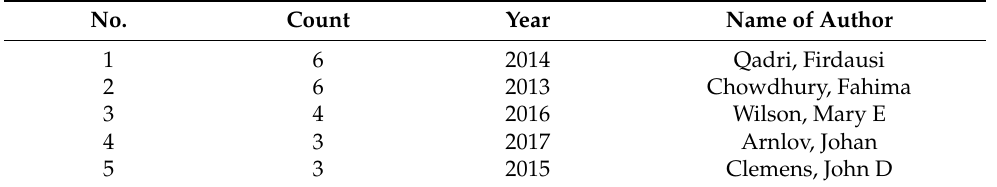
Table 3. The top 5 most productive authors of studies of epidemic control based on big data research, extracted through CS analysis.